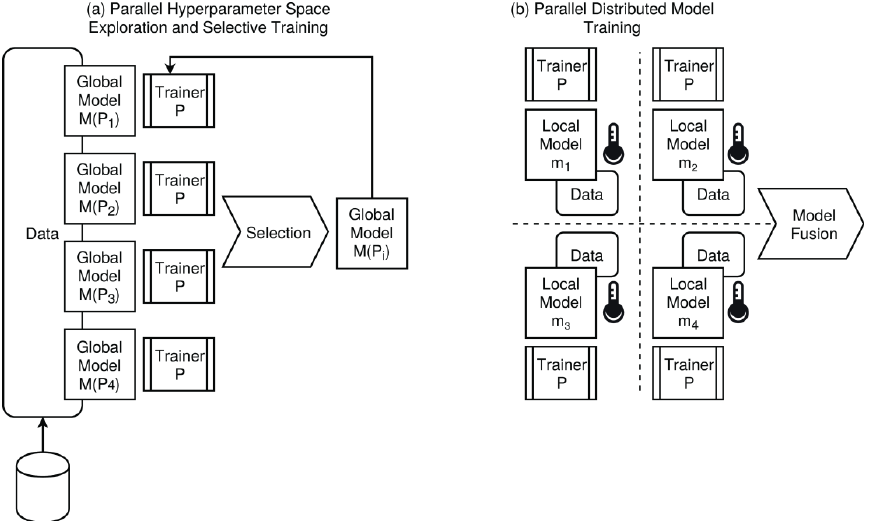
Figure 12. Parallel multi-model training: ( a ) model diversity; ( b ) distributed models using local sensor data.